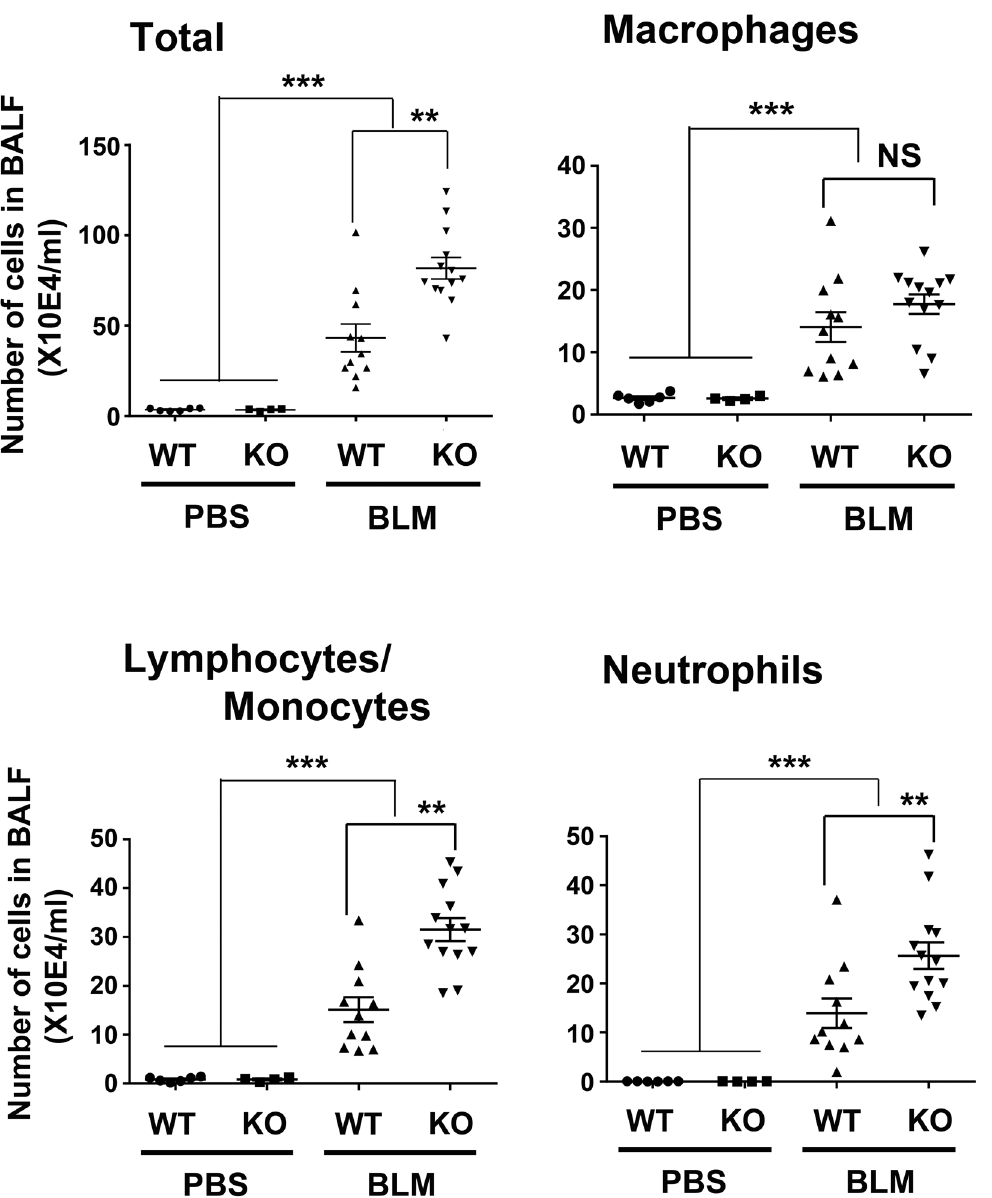
Fig 3. Increased inflammatory cells in BLM-treated Scgb3a2 -null lungs. Total inflammatory cell numbers, macrophages, lymphocytes/monocytes, and neutrophils in BALF of wild-type (WT) and Scgb3a2 -null (KO) mice intubated with BLM or PBS as control. The mean ± SD from N > 5 in each group are shown. ** P < 0.01, and *** P < 0.001 by one-way ANOVA. NS: not